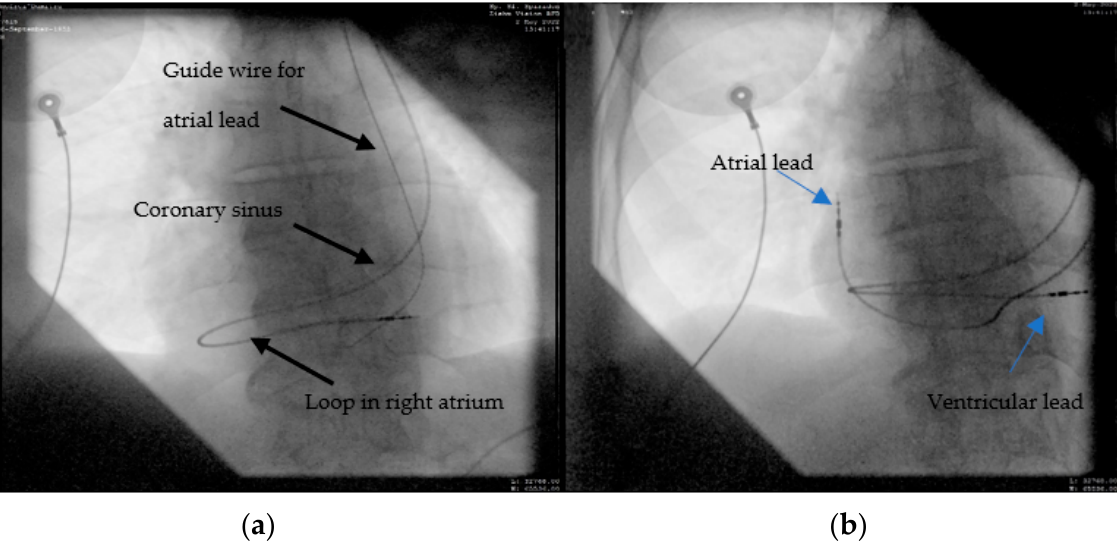
Figure 5. Atrial and ventricular lead placement through PLSVC and coronary sinus: ( a ) the ventricular lead crossing a large coronary sinus and leaving behind a significant loop in the right atrium; ( b ) the final result with the leads at the level of the right atrium and right ventricular apex.